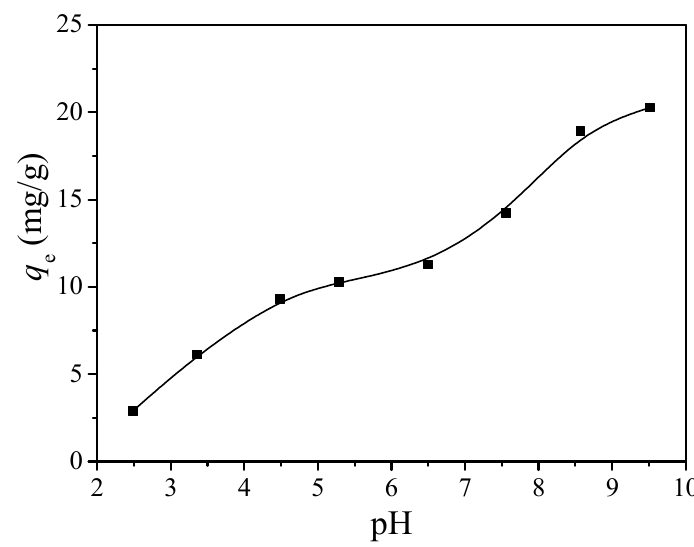
Figure 4. E ff ect of the solution pH on Cd(II): m / V = 84 mg / L, t = 24 h, C 0(Cd) = 10 mg / L, T = 30 ◦ Figure 4. Effect of the solution pH on Cd(II): m / V = 84 mg/L, t = 24 h, C 0(Cd) = 10 mg/L, T = 30 °C.